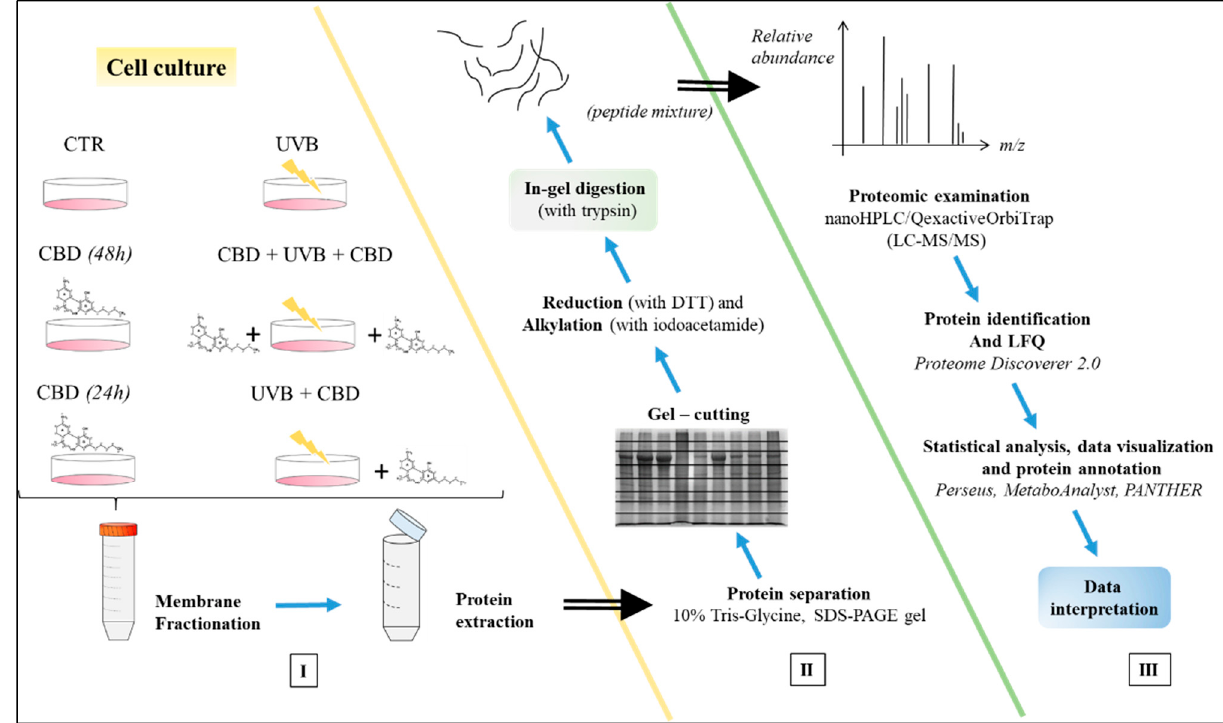
Figure 1. The main stages of proteomic analysis of keratinocyte membranes: I. Preparation of keratinocytes (six groups as described above) for obtaining cell membranes and extraction membrane proteins; II. Preparation of proteins for proteomic analysis; III. Proteomic qualitative–quantitative analysis.